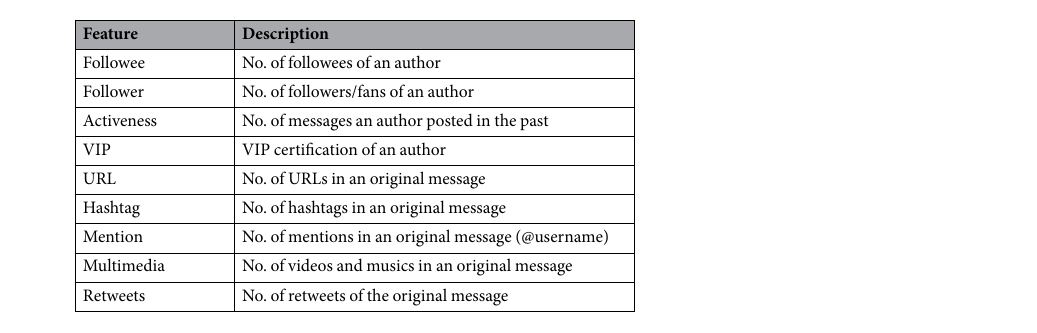
Table 2. Generated Features for the prediction of b